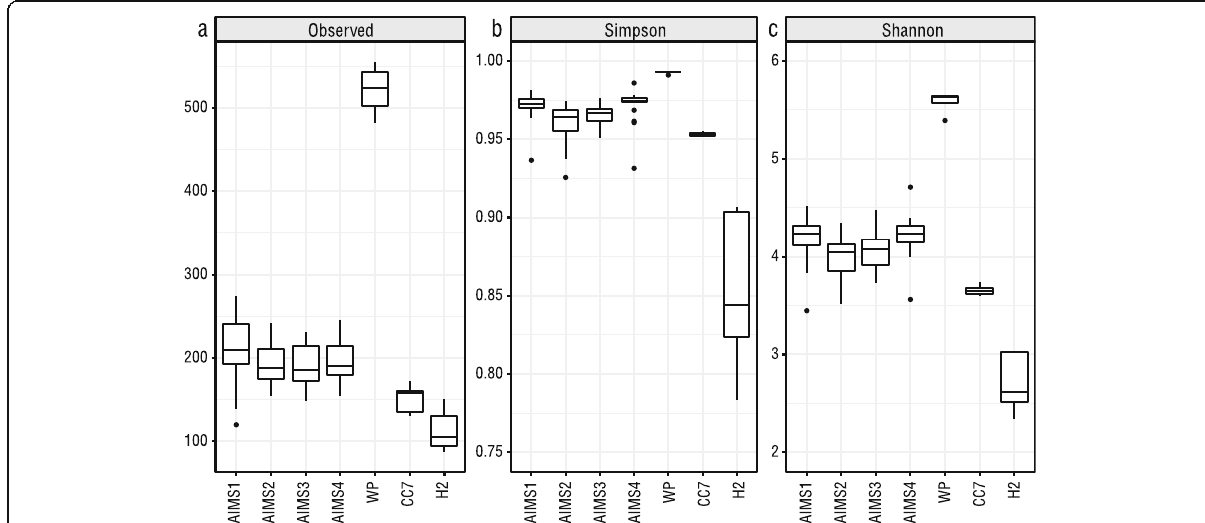
Fig. 2 Alpha diversity of sample types. Alpha diversity was assessed by average number of observed ASVs – higher values indicate greater richness ( a ), Simpson diversity index – higher values indicate greater evenness ( b ), and Shannon diversity index – higher values indicate greater overall alpha diversity ( c ). WP = wild